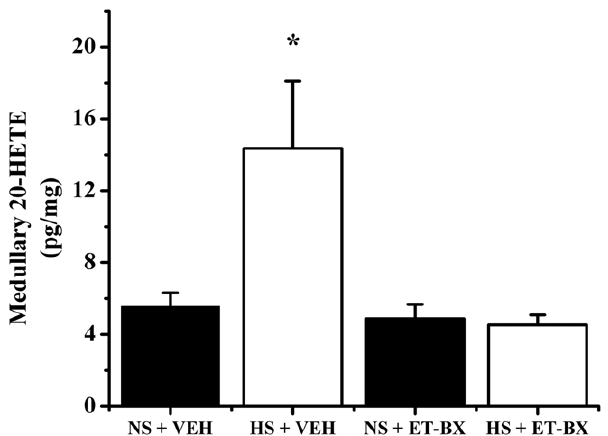
Figure 3. Renal medullary tissue levels of 20-HETE in response to blockade of medullary ET-B receptors. In response to increasing salt intake in male SD rats, renal medullary 20-HETE levels are significantly elevated (5.6 6 0.75 vs. 14.3 6 3.7, n=4 and n=7 respectively). With chronic intramedullary blockade of ET-B receptors, this response is completely abolished (4.9 6 0.79 vs. 4.5 6 0.55, n=5 and n=6 respectively). * denotes p , .05 vs. NS + VEH.